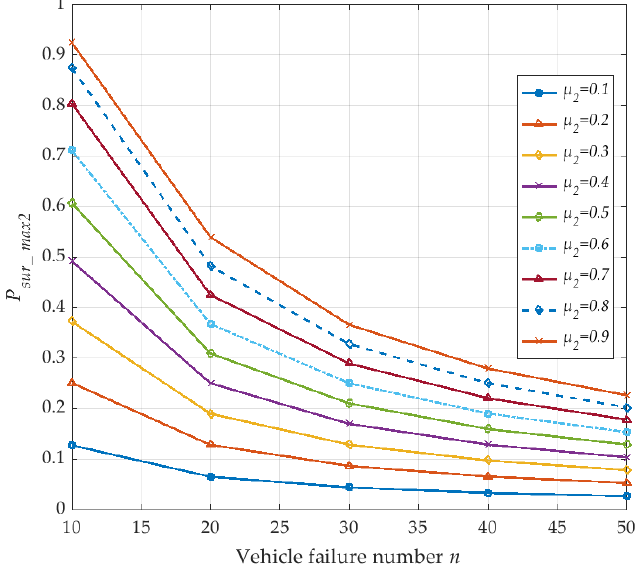
Figure 7. The maximum survival probability of the V2I network with vehicle failure number n (corresponding to μ 2 ).